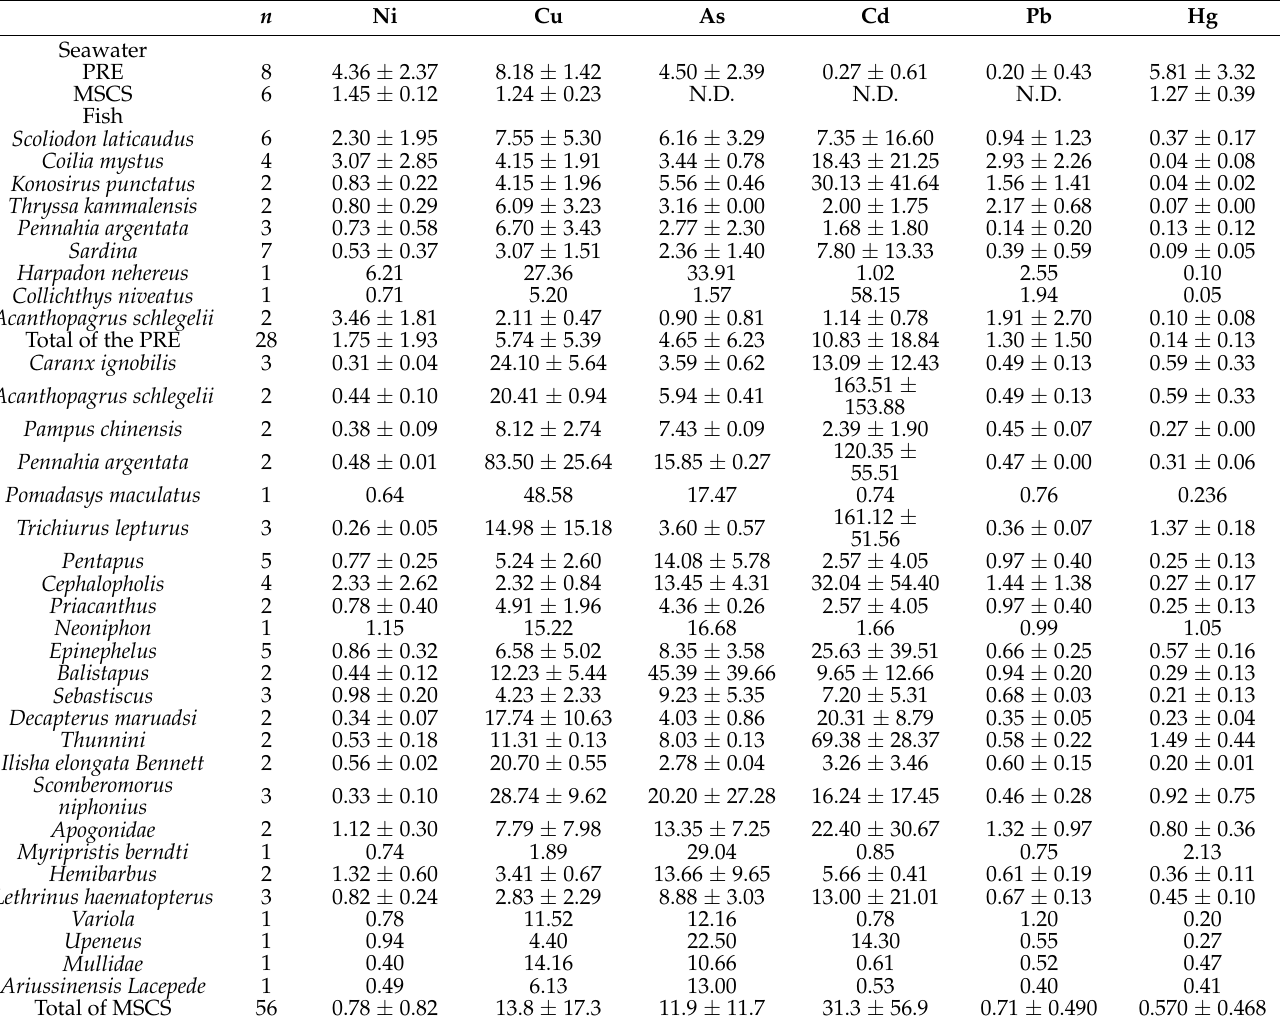
Table 1. Heavy metal concentrations (mean ± 1 SD) in seawater and each fish species (dry weight) collected from the Pearl River Estuarine (PRE) and middle of the South China Sea